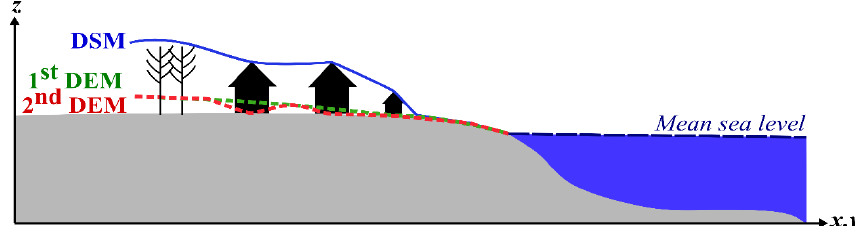
Figure 3. Topographic corrections performed on the DSM and the 1st DEM. The 2nd DEM is used as new topography in the TUNAMI two-layer model.